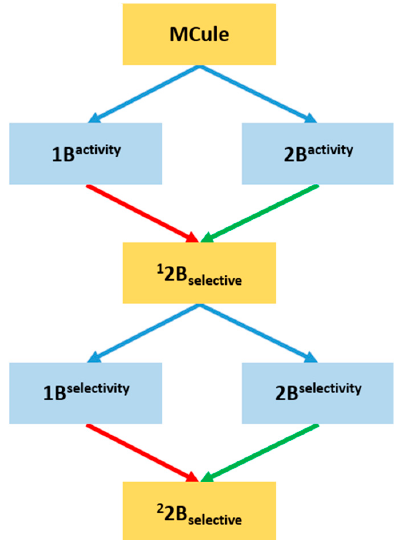
Figure 3. Classification procedure for putative 2B selective compounds. Green arrows represent positive classification and red arrows represent negative classification.